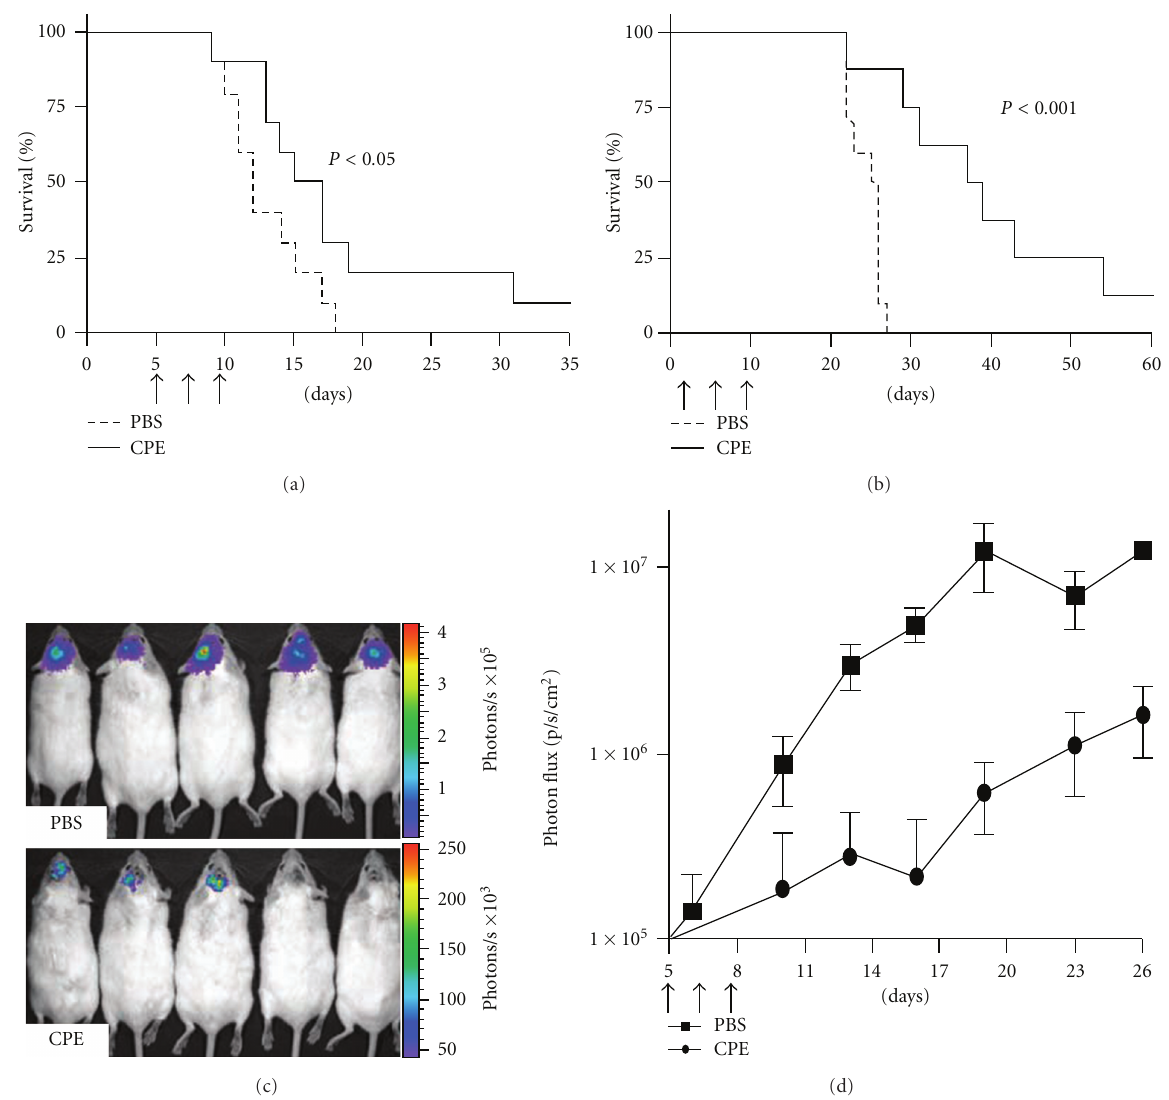
Figure 3: E ffi cacy of CPE in the treatment of breast cancer brain metastasis. (a, b) Brain tumors were established in mice using the human breast cancer cell line MDA-MB-468 and the murine breast cancer cell line NT2.5-luc. Tumors were treated by intracranial administration of 0.5 μ g CPE versus PBS on days 5, 7, and 9. (c, d) For the NT2.5-luc brain tumor model, noninvasive bioluminescent imaging was done twice per week beginning on day 4. Bioluminescent images from five representative mice are shown for each experimental group at day 19 (c). Photon flux was measured over the indicated time course as an indication of tumor growth (d). Di ff erences in survival between experimental groups were analyzed using the log-rank test. Reproduced with permission from